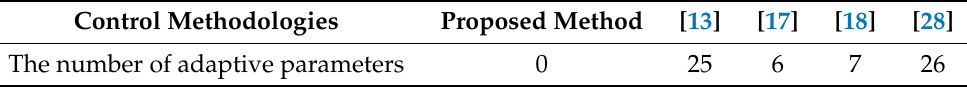
Table 1. The comparison of approximation